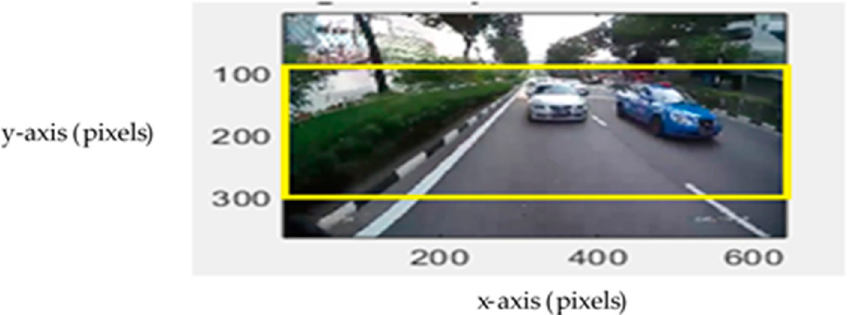
Figure 7. Region of interest.